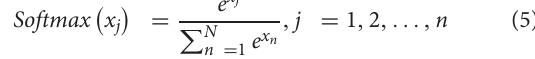
block, and the other is the output feature map of the same